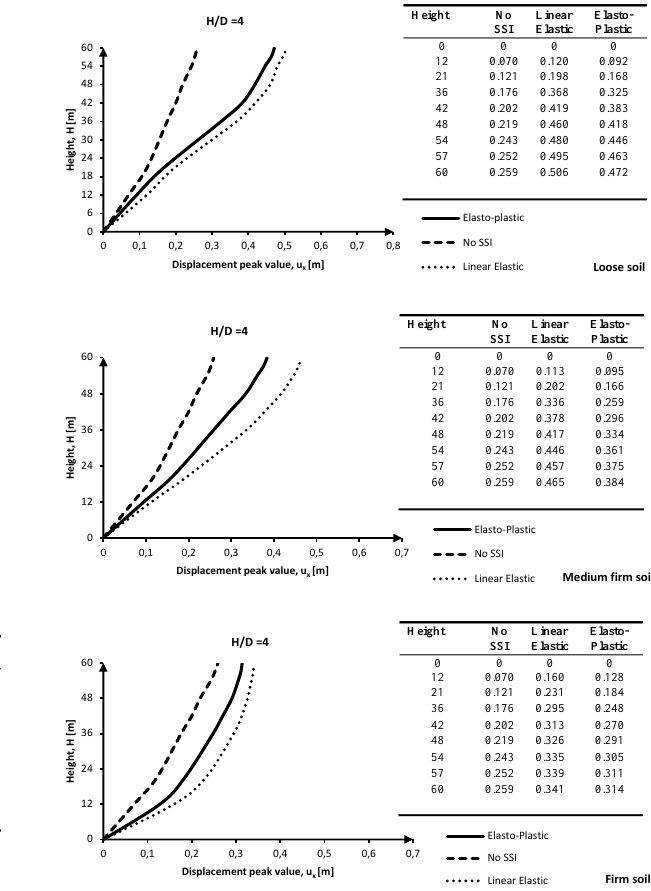
Fig. 4. Variation of peak lateral response of the building depending on different soil conditions in the case of H/D = 2 for the 1989 Loma Prieta earthquake input motion.